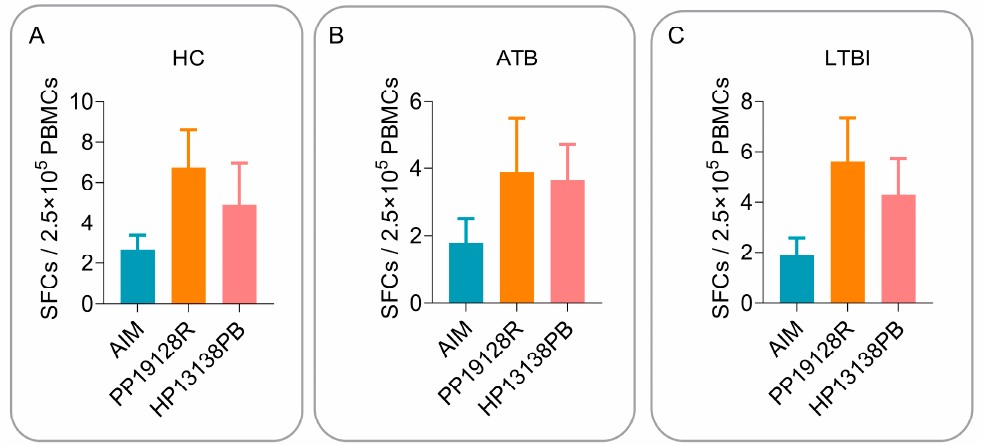
Figure 9. The number of PP19128R-specific IFN- γ + T lymphocytes. The purified PP19128R vaccine (experiment group), AIM (negative control), and our previously designed vaccine HP13138PB [50] (positive control) were used to stimulate PBMCs collected from HCs ( A ), ATB patients ( B ), and LTBI individuals ( C ) in vitro. The number of antigen-specific IFN- γ + T lymphocytes was detected by ELISpot. SFCs: the number of spot-forming cells; HCs: healthy controls; ATB: active tuberculosis; LTBI: latent tuberculosis infection.